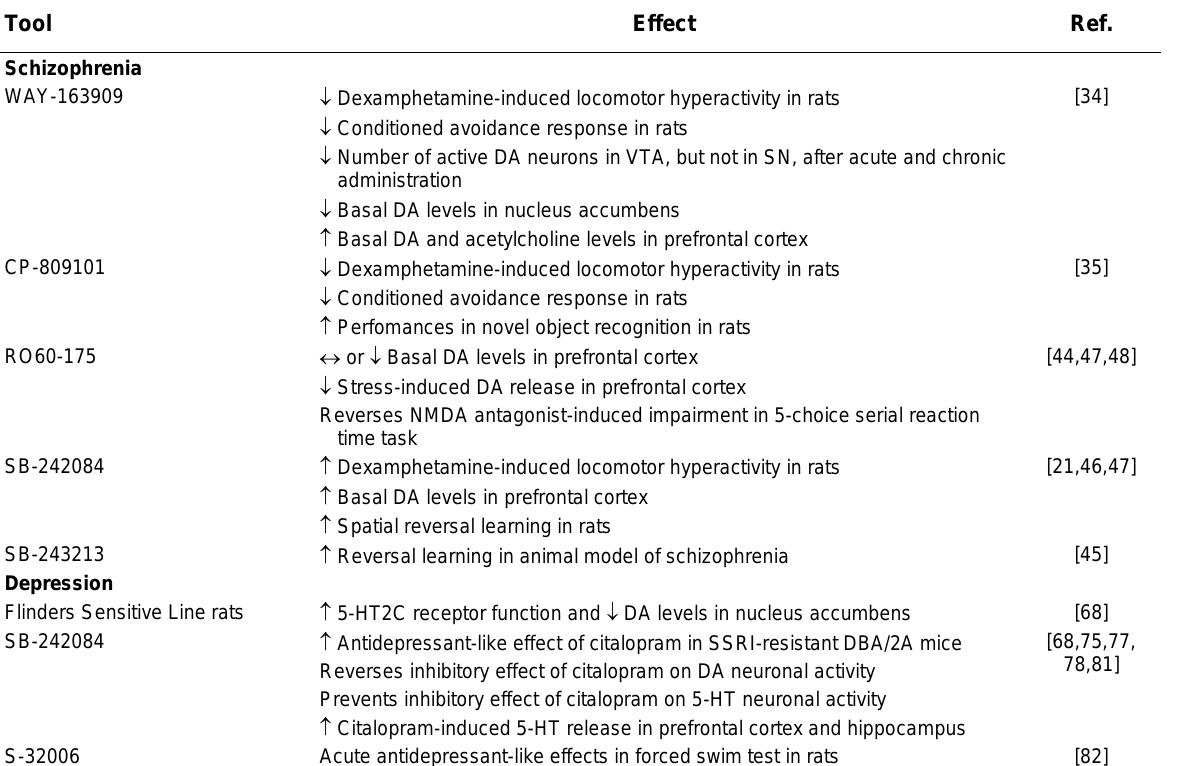
Main Preclinical Evidence Supporting a Therapeutic Potential for 5-HT Tool Effect